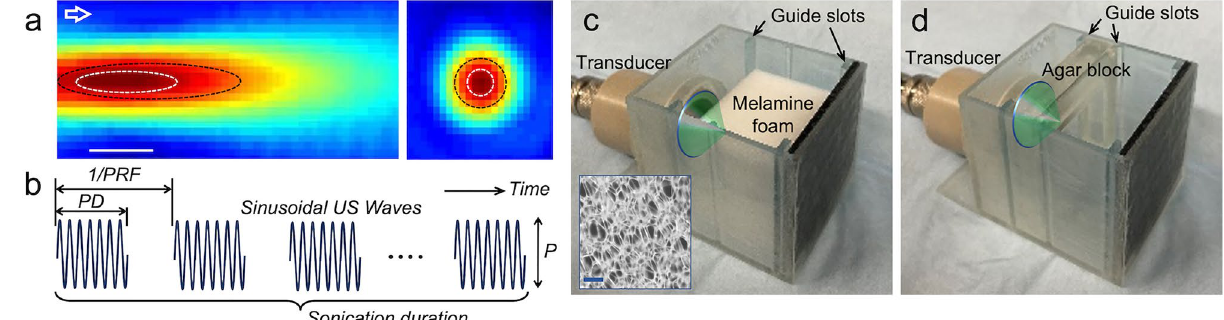
Figure 1. Schematics of the experimental setup and dye infiltration test. ( a ) Pressure profile along the longitudinal and transverse plane of the FUS focus (bar = 10 mm). ( b ) Illustration of the temporal features of sonication parameters used in the experiment. ( c ) Experimental setup for TbO dye infiltration into the melamine block (shown without the TbO solution, inset: microscopic view of the foam, bar = 100 μm). ( d ) A setup for sonicating the agar block shown without the dye solution. The chamber contained guide slots to position the acoustic focus at 1 mm in front of the surface of the block. The green cones illustrate the FUS sonication to the